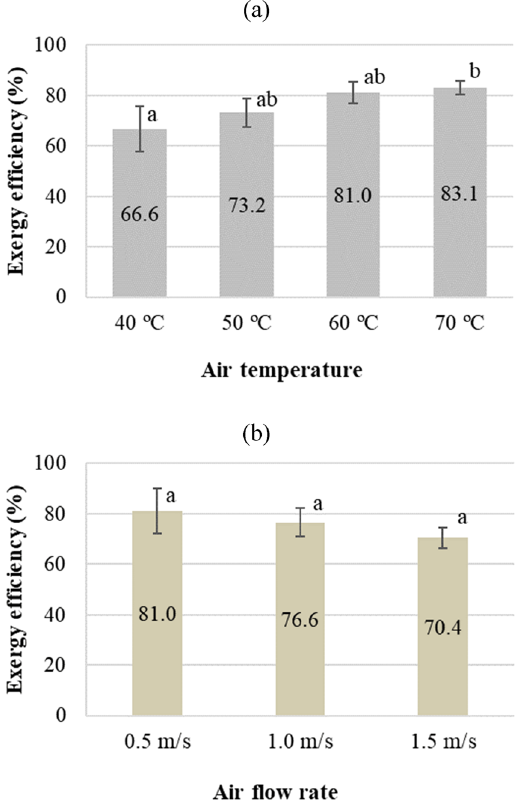
Figure 5: Mean values of exergy e ffi ciency for the drying of potato slices for: ( a ) fi xed temperature or ( b ) fi xed fl ow rate ( bars with the same letter correspond to the values not signi fi cantly di ff erent according to ANOVA and Tukey ’ s post hoc test with p < 0.005 )